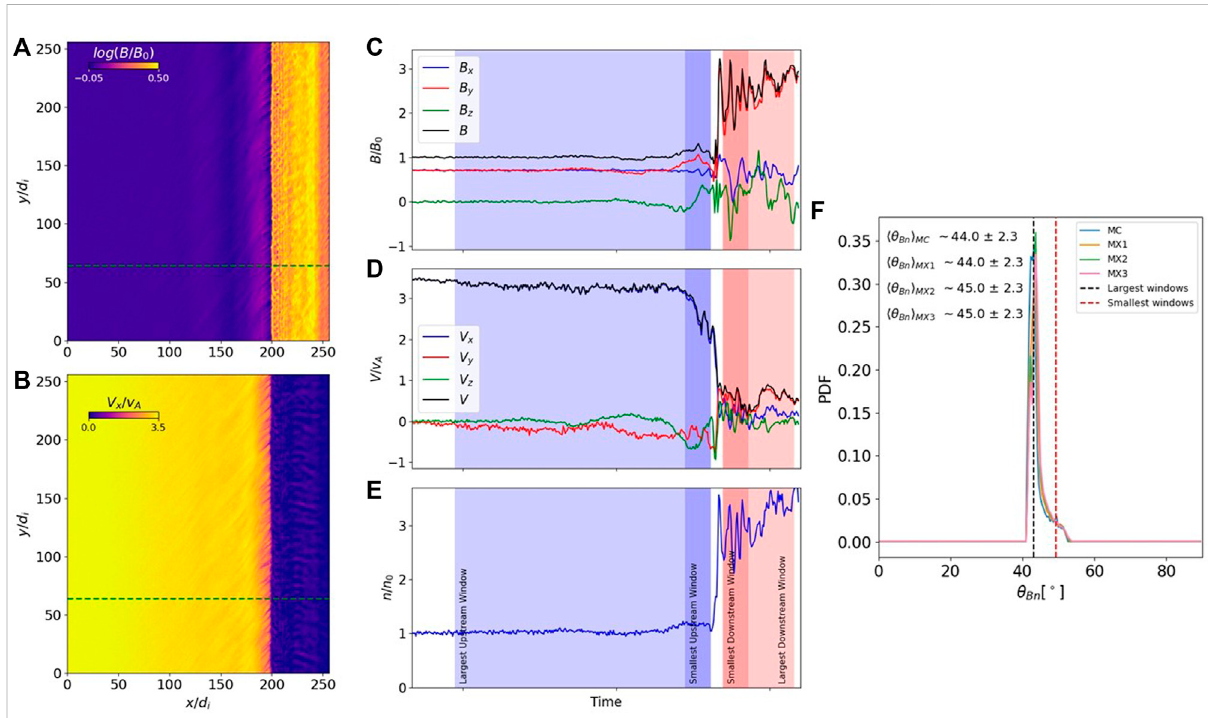
FIGURE 3 SnapshotofHybridPICsimulationof45 ° degreesshockcapturedatsimulationtime T Ω ci =40.Panels (A) and (B) showmagnetic fi eldmagnitude and proton bulk fl ow speed along the shock nominal shock normal direction, respectively. In the middle panels, are shown one-dimensional signals of magnetic fi eld and its components (C) , proton bulk fl ow speed magnitude and its components (D) and proton density (E) as seen by a virtual spacecraft crossing the shock along the green-shaded line in panels (A,B) . In these panels, the smallest/largest averaging windows used for the upstream/downstream regions are highlighted (red/blue shaded panels). Finally, PDF distributions of θ Bn obtained with MC, MX1, MX2 and MX3 methods are shown in (F)